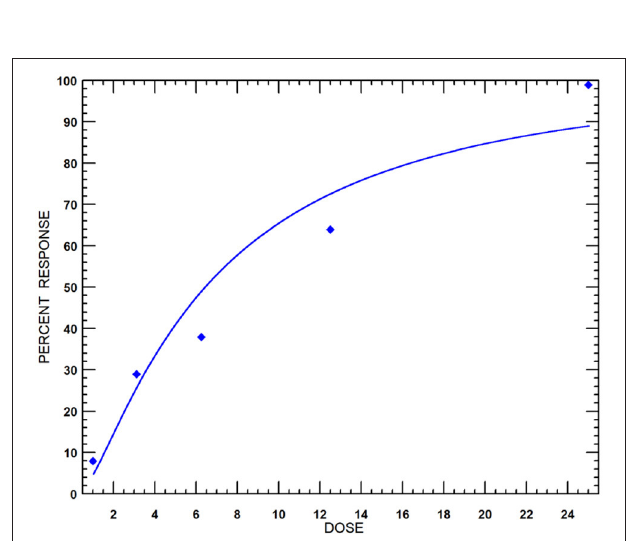
FIGURE 6 | Dose-response curves of MEO against F. oxysporum f. sp. lycopersici isolate TOFU-IHBT.